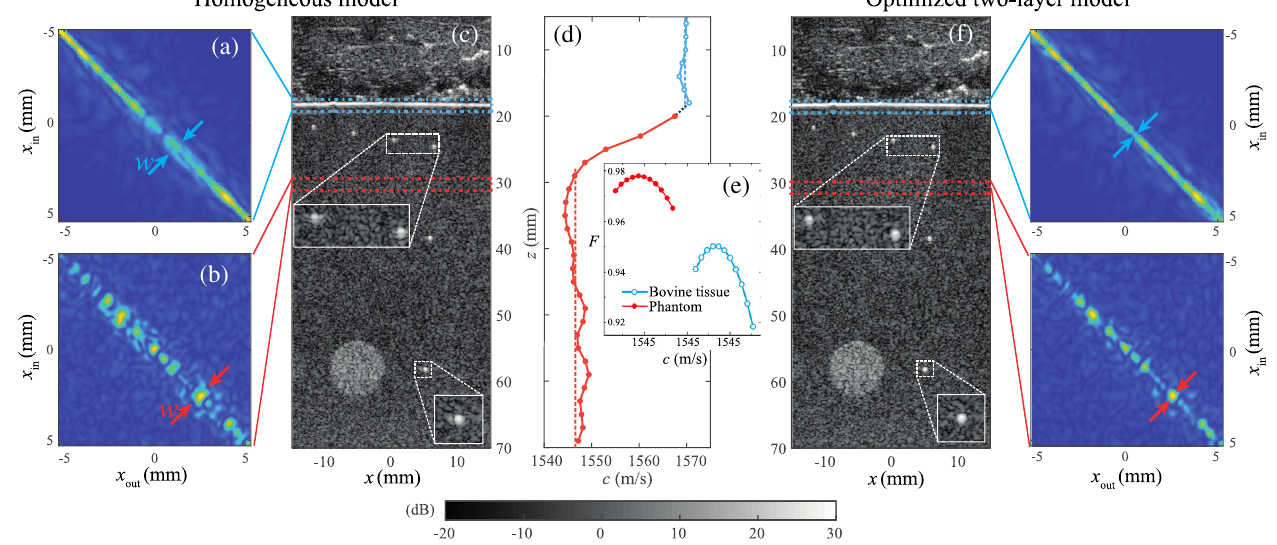
FIG. 2. Matrix approach applied to wave velocity mapping of the bovine tissue and phantom system described in Fig. 1(a). (a),(b) The matrix R xx is displayed at depth z ¼ 18 and 30 mm, respectively, assuming a homogeneous wave velocity model ( c ¼ 1542 m s − 1 ). The local image resolution w is extracted from each antidiagonal of R xx . (c) Corresponding ultrasound image built from the confocal elements of R xx . (d) The optimized wave velocities are displayed versus depth for the bovine tissue, found using a homogeneous model (blue open symbols), and the phantom, found using a bilayer model (red solid symbols). (e) The focusing criterion F , averaged over the depth ranges [17.4, 19.4] (blue circles) and [30, 32] mm (red disks), is displayed versus the wave velocity hypothesis c . (f) Ultrasound image built from the confocal elements of R xx using the optimized wave velocity model ( c t ¼ 1573 m = s, c p ¼ 1546 m = s). (g),(h) Corresponding reflection matrices R xx are shown for depths z ¼ 18 mm and z ¼ 30